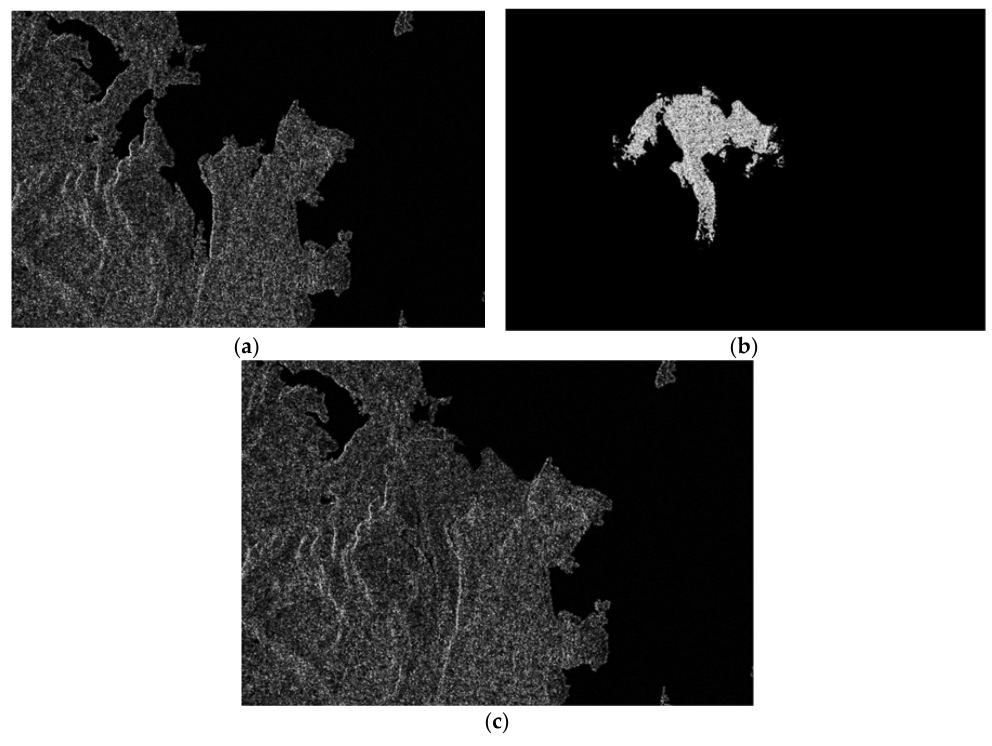
Figure 6. Comparison between the SAR images before and after SAR deceptive jamming: ( a ) master image before jamming; ( b ) deceptive jamming template; and ( c ) master image after jamming.